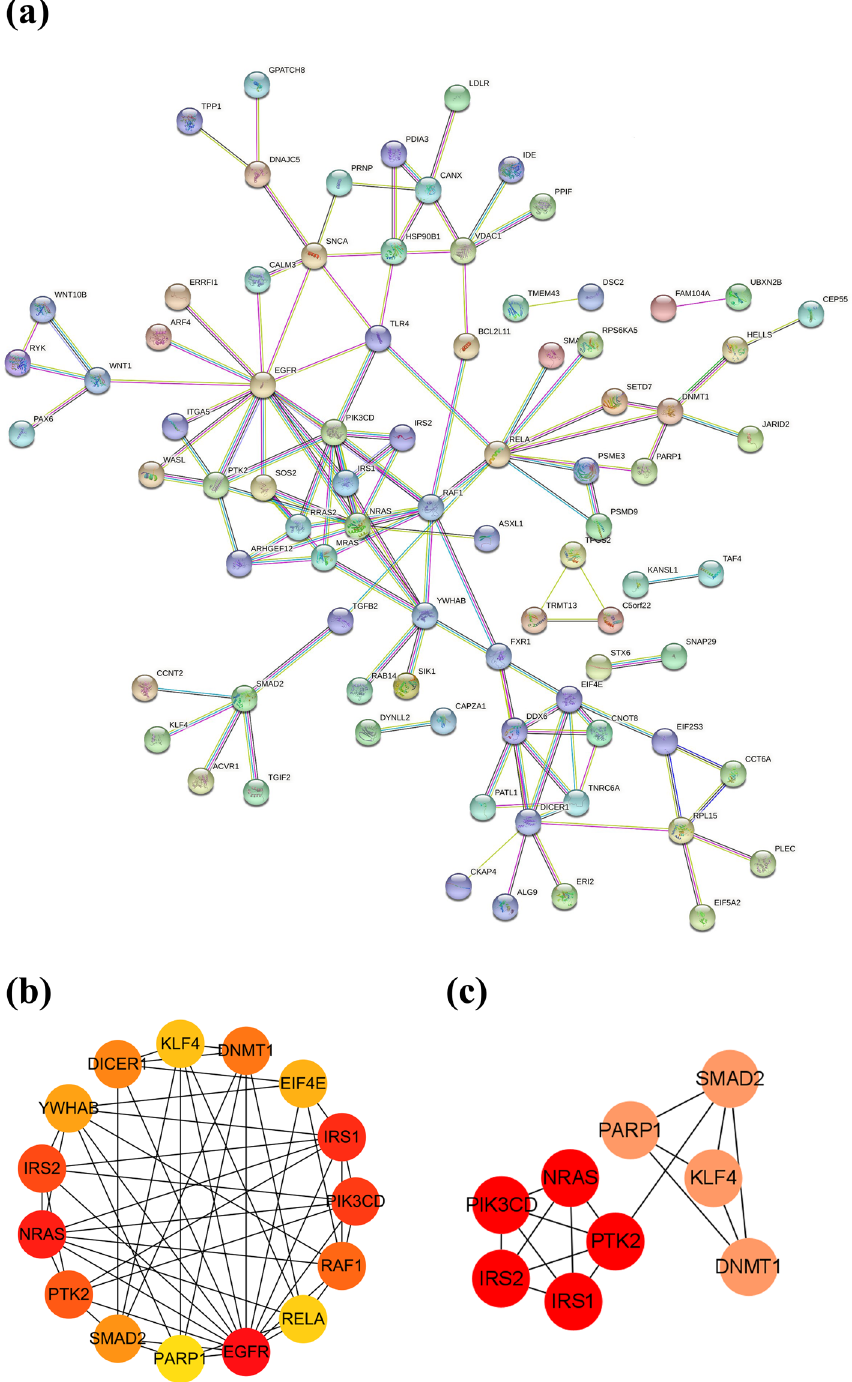
Figure 7: PPI network construction and exploration of the key genes. ( a ) PPI network of 193 consensus genes. ( b ) Results of the cytoHubba topological analysis. ( c ) MCODE network module diagram showed the key genes and their